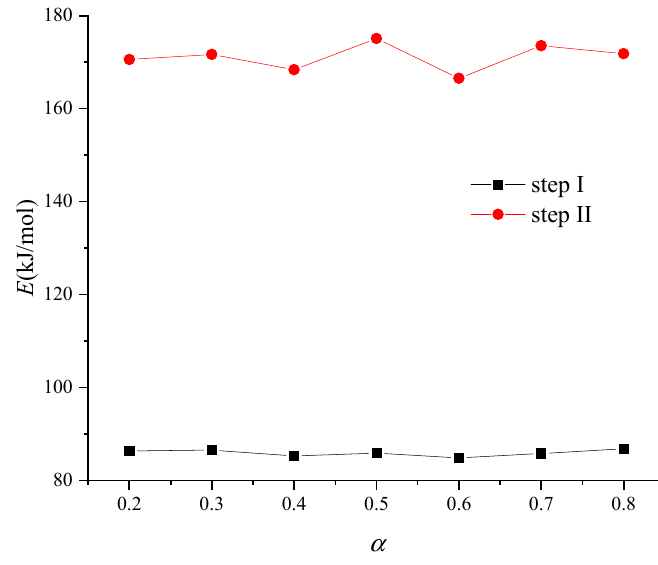
Figure 6. Relationship between activation energy and conversion rate.